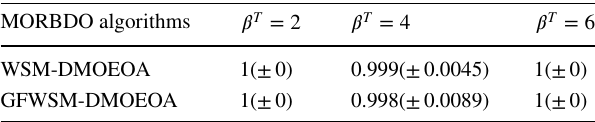
Table 9 The accuracy index Acc of the two MORBDO algorithms on the first MORBDO test example with different target reliability levels. Each result is in the form of mean ± standard deviation MORBDO algorithms